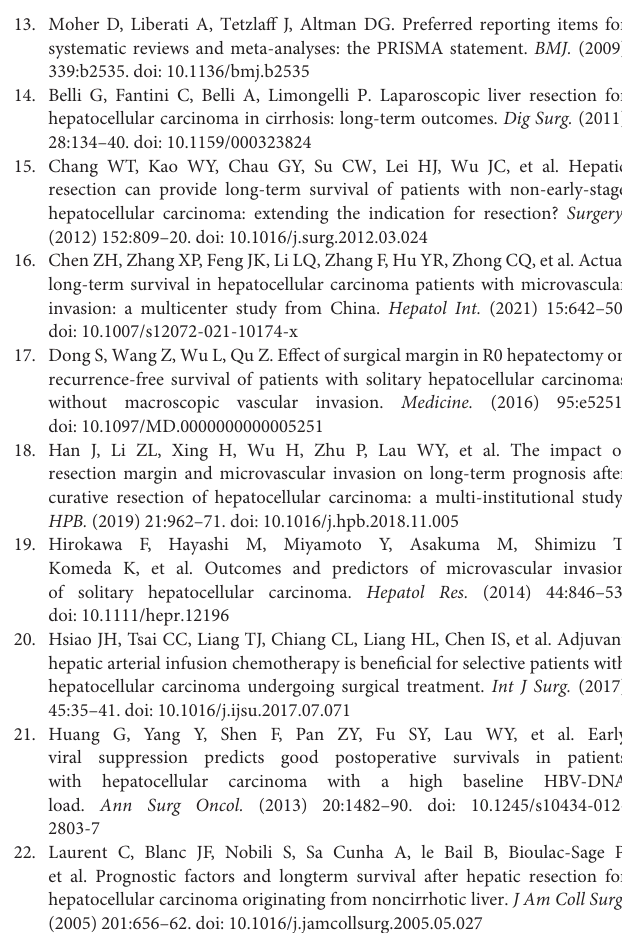
Supplementary Figure 1 | Sensitivity analysis of OS for HCC patients receiving wide surgical margin. Supplementary Figure 2 | Sensitivity analysis of DFS for HCC patients receiving wide surgical margin. Supplementary Table 1 | Quality assessment of studies